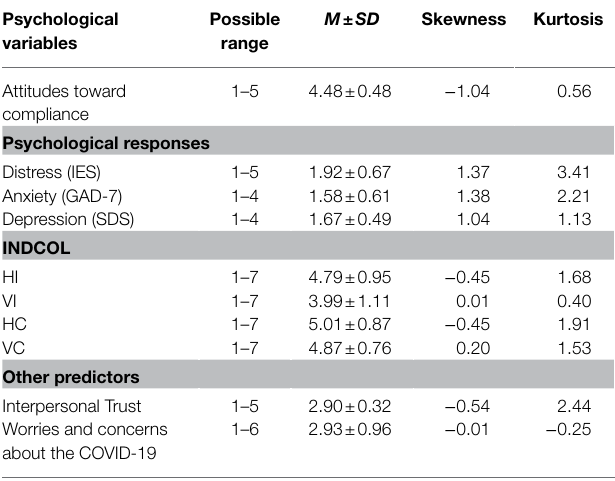
TABLE 1 | Descriptive statistics for key variables ( n =